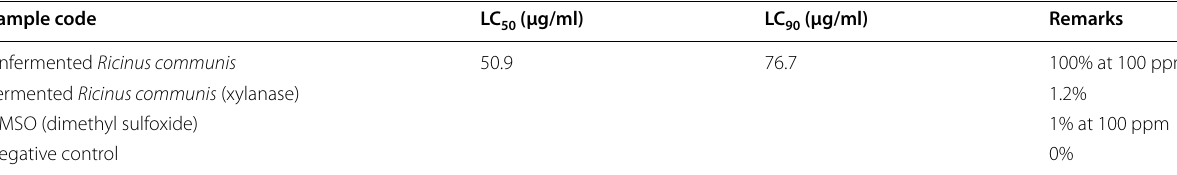
Table 1 Cytotoxic activity of Ricinus communis (unfermented/fermented)